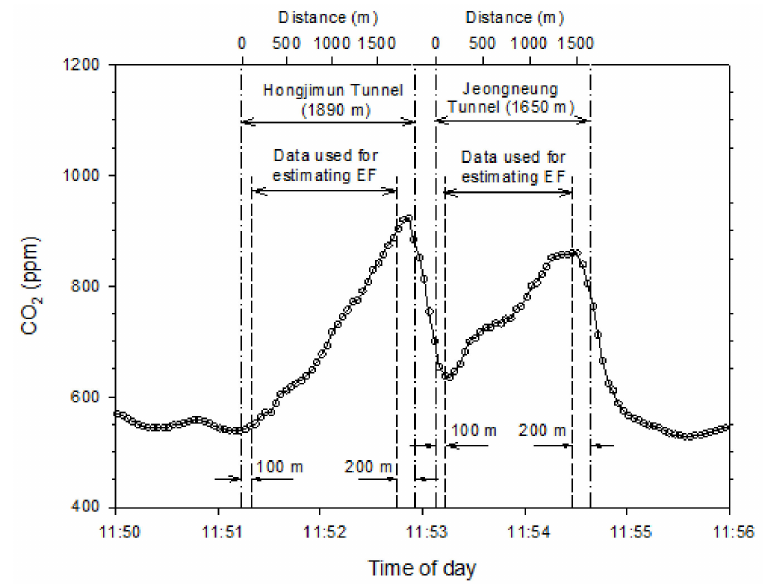
Figure 4. CO 2 concentration profile obtained on 8